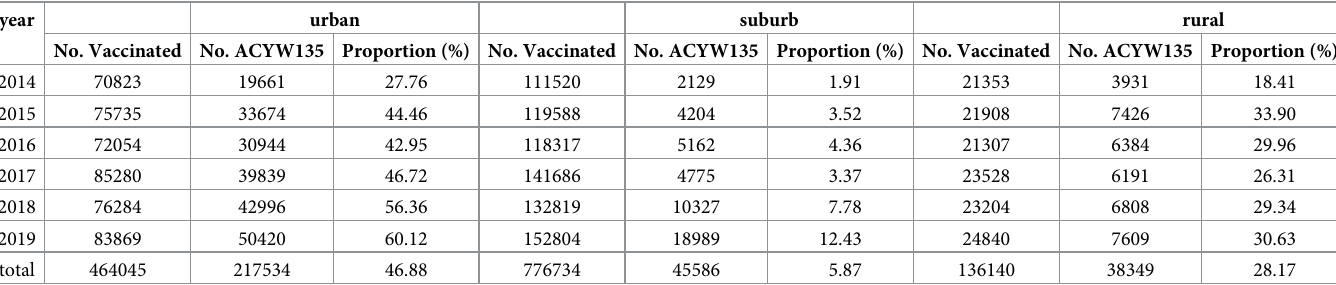
Table 3. The proportion of children using MPV-ACYW135 by geography.